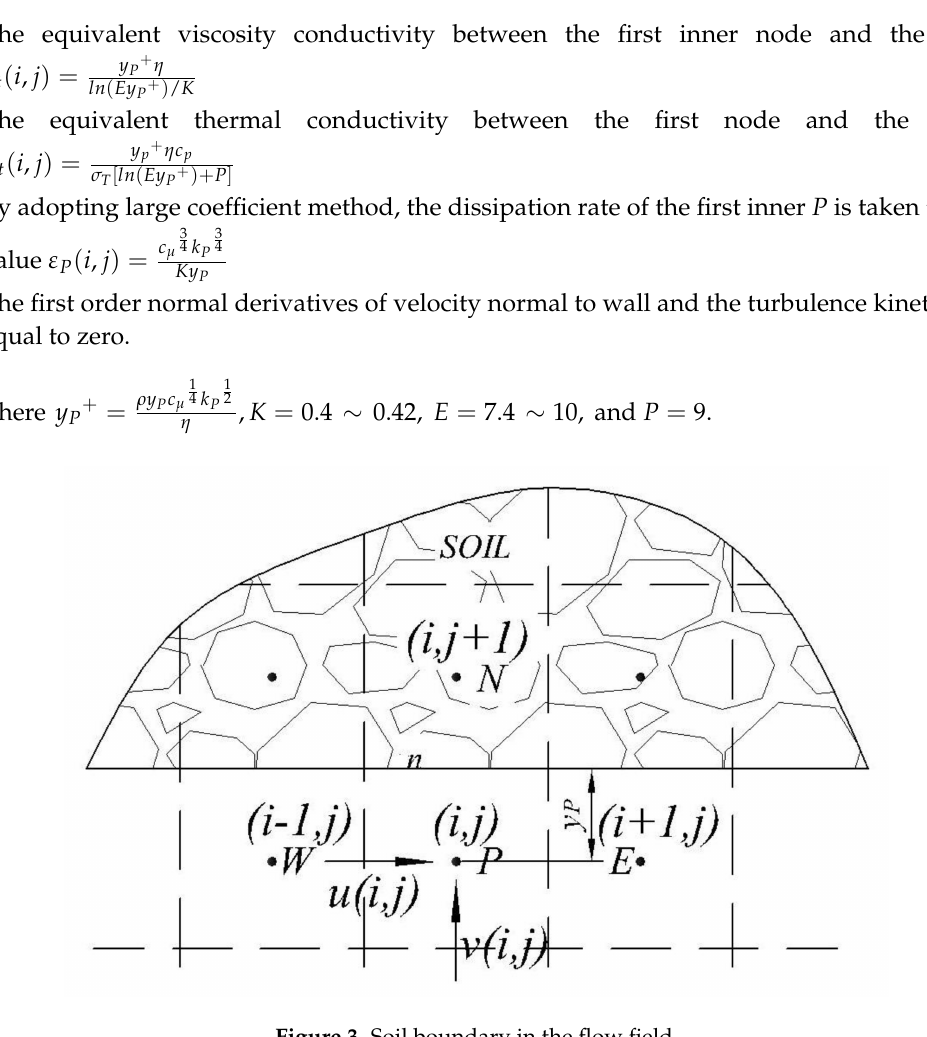
Figure 3. Soil boundary in the flow